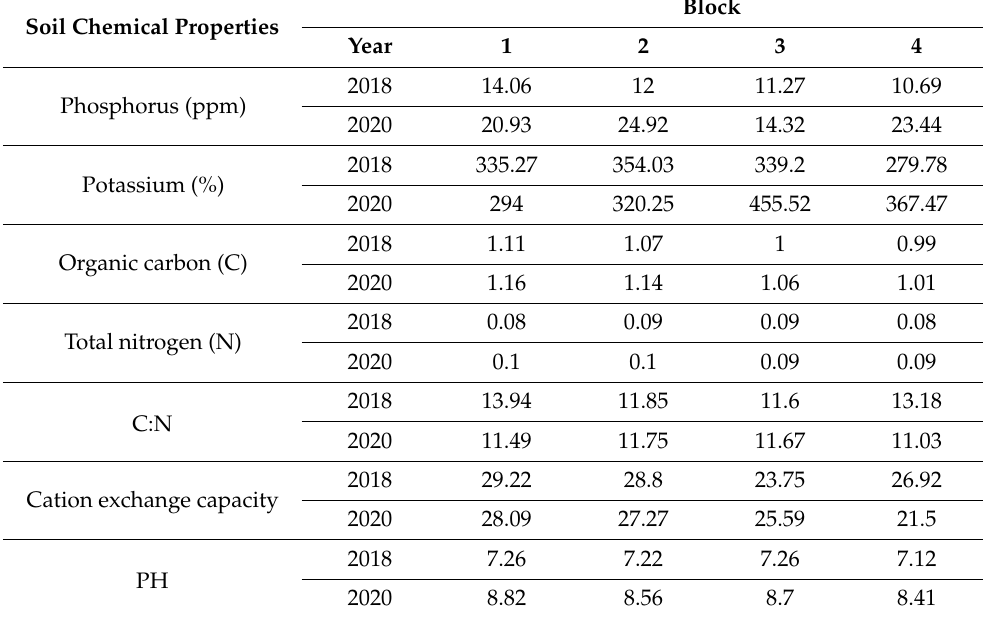
Table 6. Soil chemical properties at a depth of 0–40 cm in the experimental blocks at the start and end of the